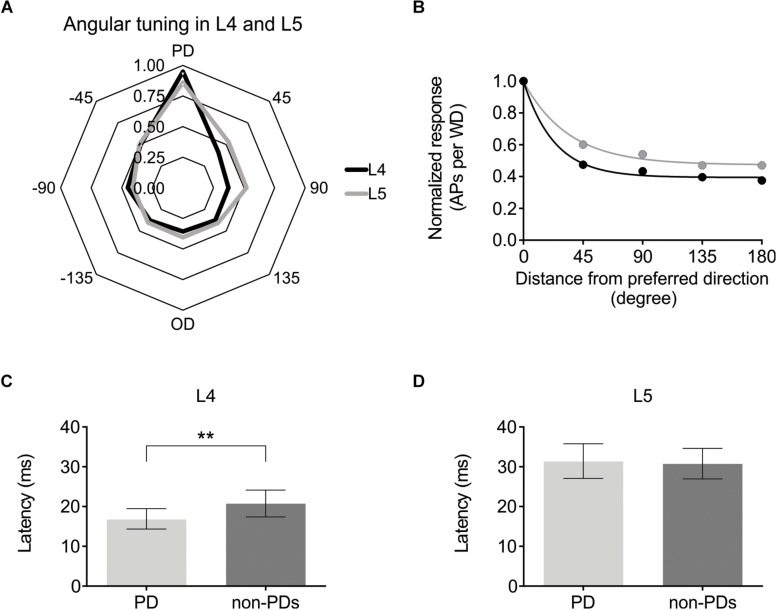
Angular direction is encoded in both L4 and L5 pyramidal cells, albeit with different strength. (A) Averaged whisker-evoked response [WER; number of spikes in 100 ms time window after whisker deflection (WD)] for each direction. Preferred Direction (PD) = direction that evoked the most APs for that cell. [For (A–D) L4: n = 25 cells; L5: n = 24 cells]. (B) Same data as in (A), now plotted as distance from PD. 45° = average WER of +45 and −45 degrees WD. The larger direction selectivity index (DSI) for L4 indicates that L4 cells are on average more direction selective. (L4: DSI = 2.60; L5: DSI = 1.54). The larger the difference is between the y-coordinate at x = 0, and the last point (x = 180°), corresponding to the plateau value, and the smaller the time constant (meaning a more rapid decay), the larger the DSI. [In (A,B), the cells PD is set to 0°. 45, 90 etc. degrees are thus relative to that cell’s PD. L4 data black line; L5 data gray line]. (C) First spike median latency for the PD and for the seven non-PD directions for 22 L4 excitatory cells in control condition in both mouse lines (Ntsr1 and Gad2) (Non-PDs: 20.8 ± 3.4 ms; PD: 16.9 ± 2.6 ms; p = 0.0053, paired Wilcoxon test). (D) First spike median latency for the PD and for the seven other directions (non-PDs) for 23 L5 excitatory cells in control condition in both mouse lines (Ntsr1 and Gad2) (Non-PDs: 30.8 ± 3.8 ms; PD: 31.4 ± 4.3 ms; p = 0.6010, paired Wilcoxon test). ∗∗p < 0.01.